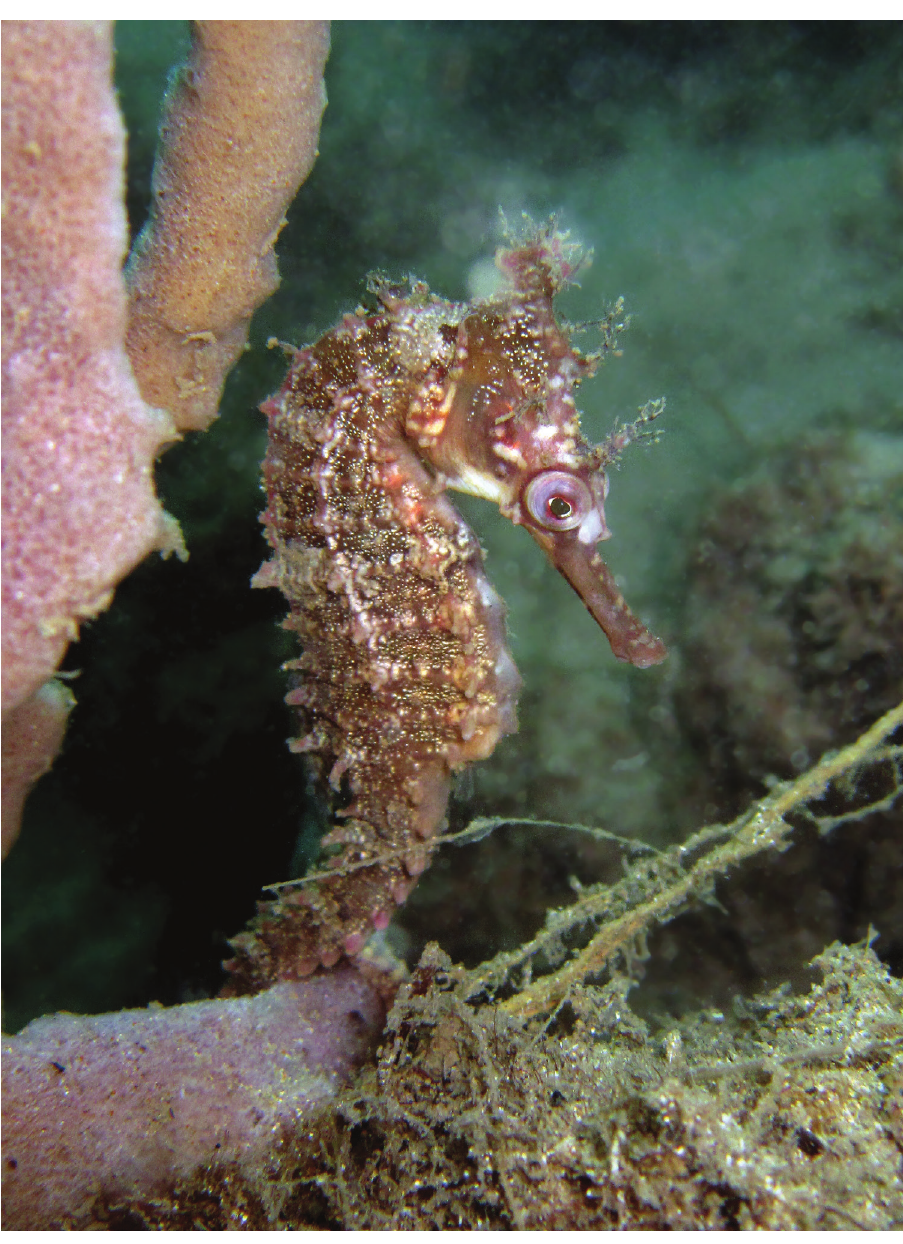
Figure 4. Hippocampus whitei in situ, adult female, Gold Coast, QLD, Australia at 5 m depth (photo- graph David